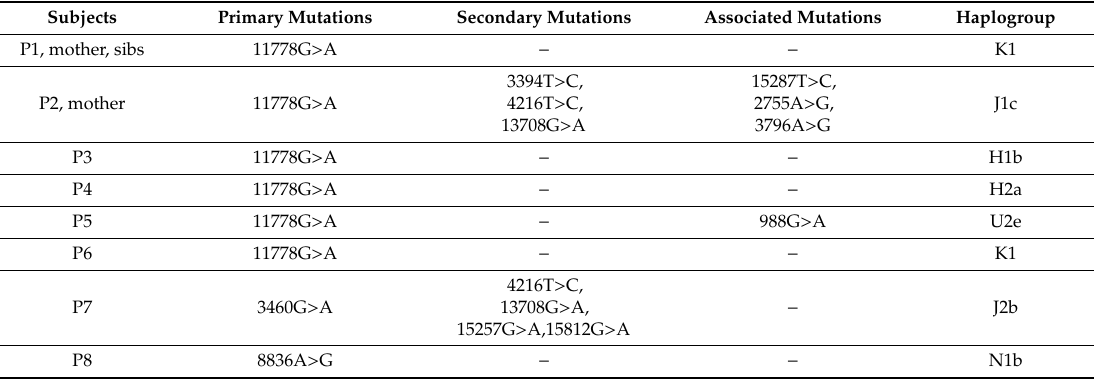
Table 1. mtDNA mutations and haplogroup characteristics in analyzed